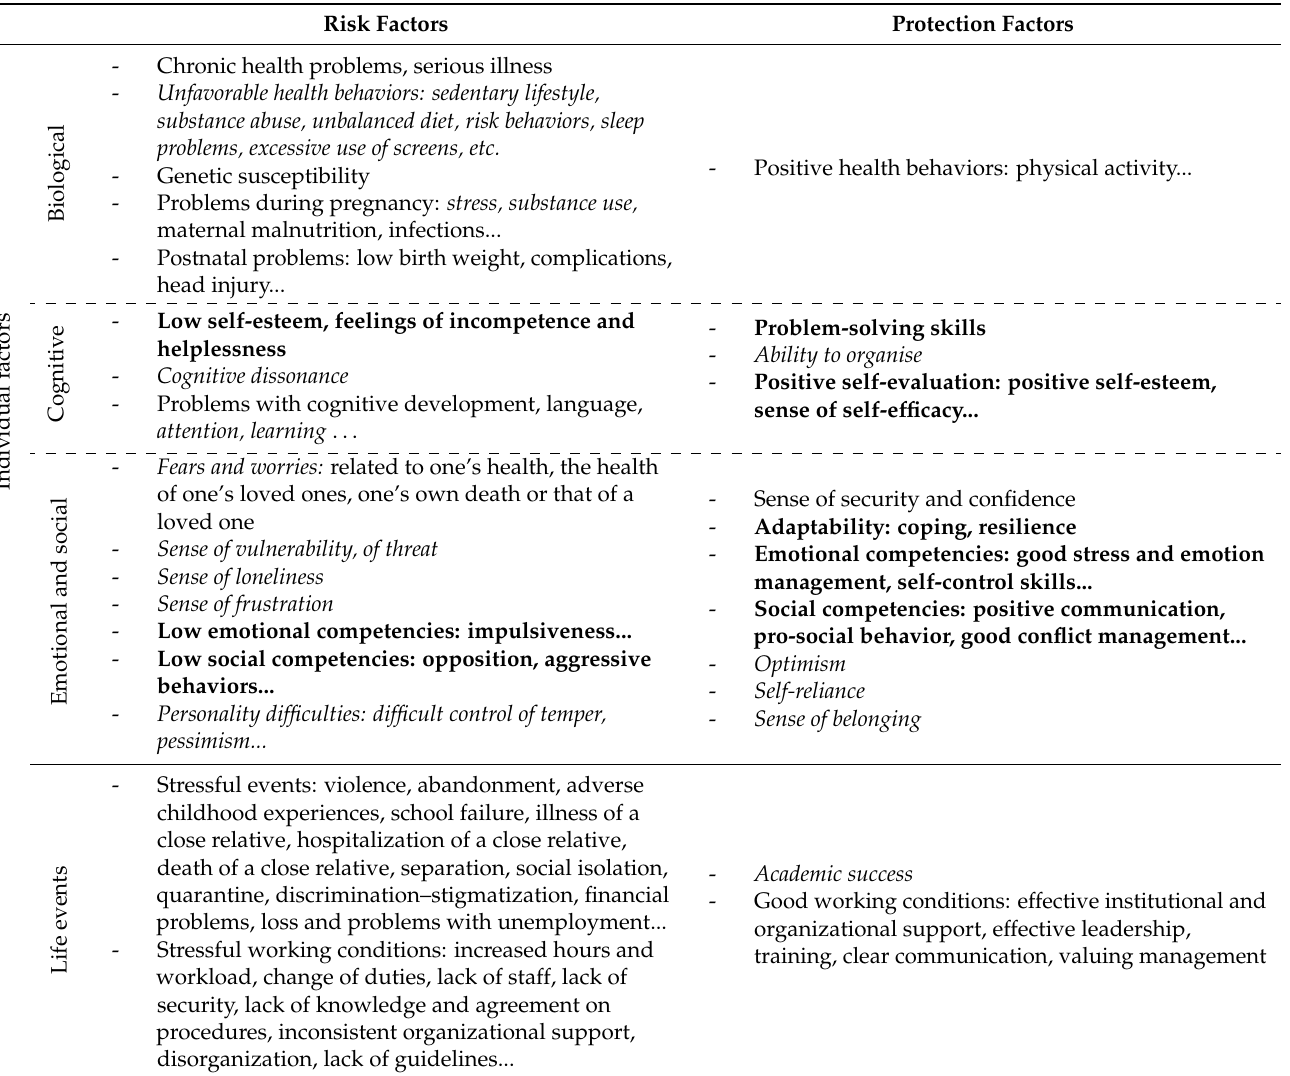
Table 1. Main generic factors of mental health and mental disorders. Risk Factors Protection Factors